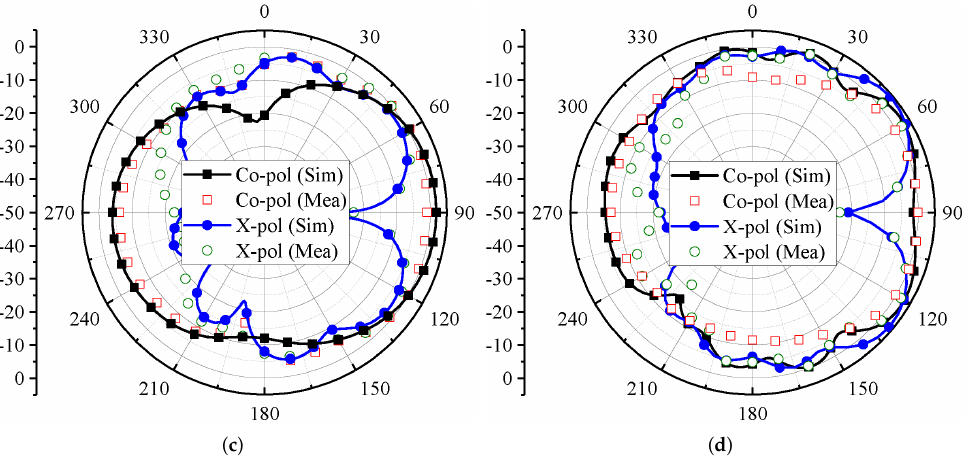
Figure 11. Modeled and actual radiation characteristics of MIMO antenna at φ = 90 ◦ for Ant 1 at ( a ) 3.4 GHz and ( b ) 4.8 GHz; Ant 4 at ( c ) 3.4 GHz and ( d ) 4.8 GHz.